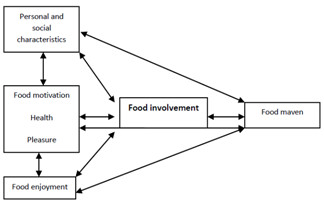
Conceptual model.